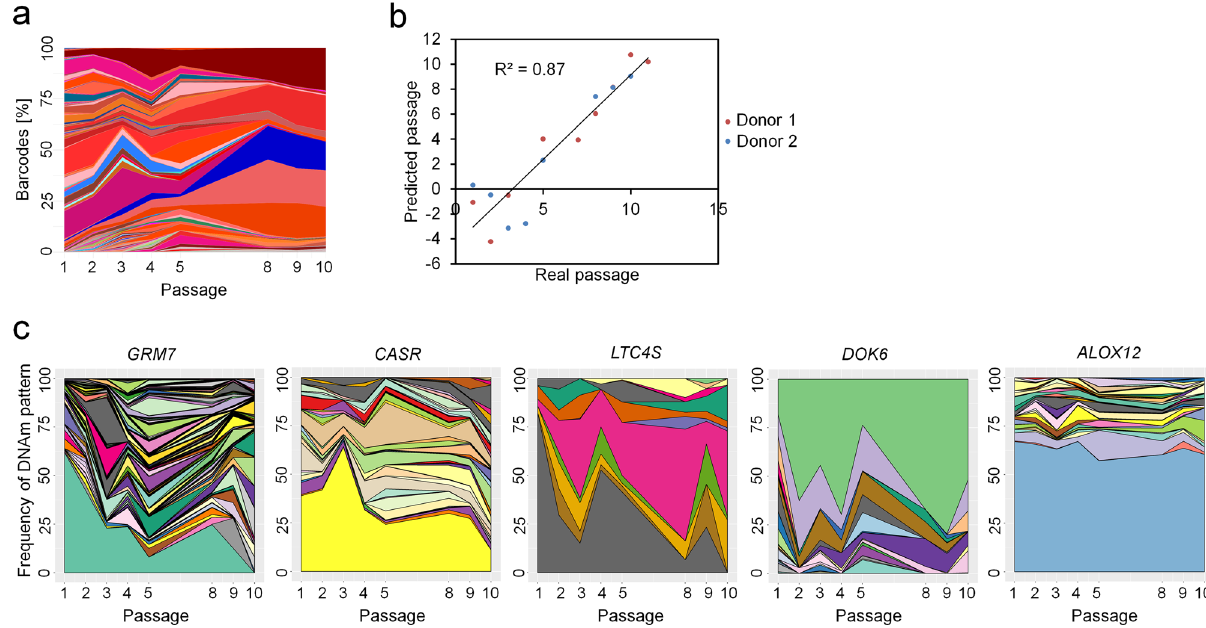
Fig. 3 DNA methylation patterns are not affected by MSC clonality. a Mesenchymal stem cells from umbilical cord were labeled with barcoded-RGB- vectors to correlate DNAm patterns with the composition of cellular subsets 30 . Deep sequencing analysis of the random barcodes demonstrates that the MSCs at passage 10 are oligoclonal. b These samples were subsequently used for DNAm analysis by barcoded bisul fi te amplicon sequencing (BBA-Seq) at ten culture-associated CpGs. The predicted passage numbers based on these DNAm levels correlated with real passage numbers. c Changes in the frequency of different DNAm patterns over the passages are depicted for the neighboring CpGs within the amplicons of GRM7 (22 CpGs), CASR (7 CpGs), LTC4S (4 CpGs), DOK6 (7 CpGs), and ALOX12 (9 CpGs). Each colored area corresponds to the frequency of one speci fi c DNAm pattern, while the sum of all pattern frequencies adds up to 100% (Supplemental Data